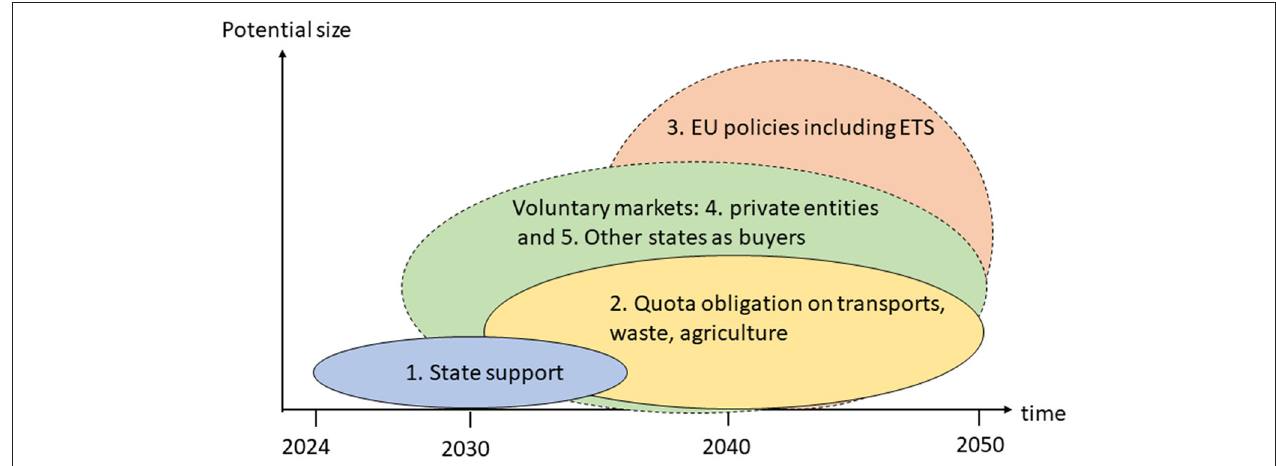
FIGURE 1 | Schematic illustration of the timing and potential volumes of the five Policy Models. The dotted lines correspond to markets that are not under the control of the Swedish state. As for the State support model (Model 1), there is a target of 1.8 Mt BECCS in Year 2030 (SOU2020:4 proposes to evaluate Model 1 in Year 2030, with no proposal as to what will happen after Year 2030); for Model 2, we assume that in the transport sector, from Year 2030a quota obligation (for example, 10%) is imposed on fossil fuel use. The quota obligation increases steadily to reach 100% in Year 2045, to compensate for reduced emissions. In the waste and agricultural sectors, we assume that a quota obligation is also introduced, possibly later than that for the transport sector; and in Model 3, we assume that BECCS credits can be used in the EU emissions trading system from Year 2035 and onwards, although the demand for Swedish BECCS is uncertain. While voluntary markets (Model 4) and state buyers (Model 5) could create significant demand, this is difficult to assess in terms of volumes and